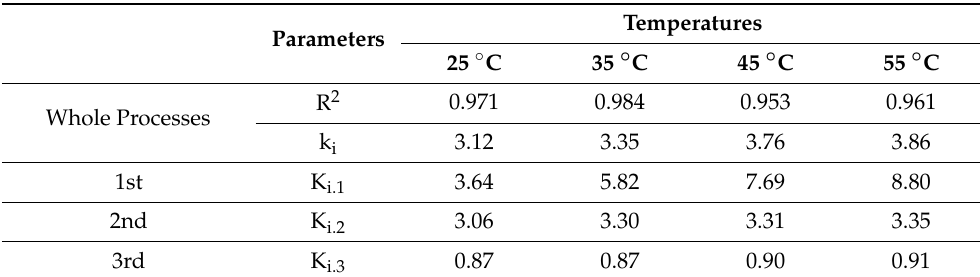
Table 5. Parameters of intraparticle diffusion model for adsorption of CR dye onto UCs at different